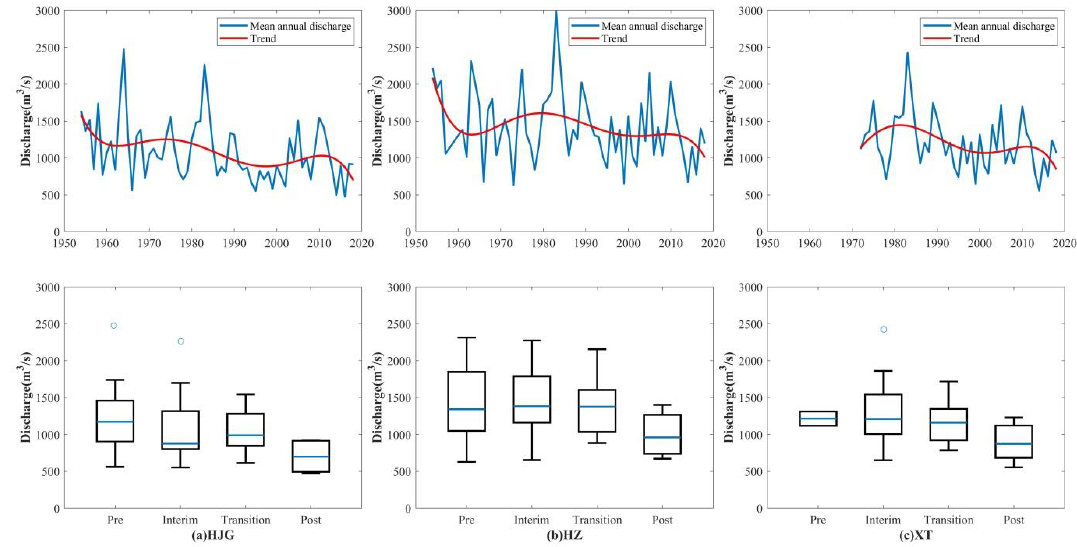
Figure 3. Mean annual discharge at three stations along the middle-lower reaches of the Hanjiang river.